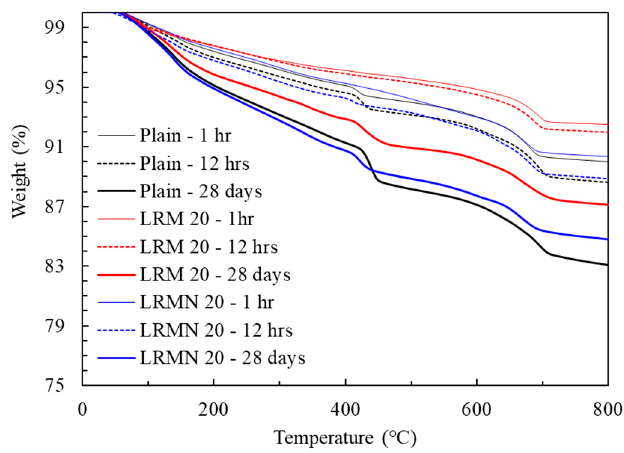
Figure 9. TG curves of the cement pastes.